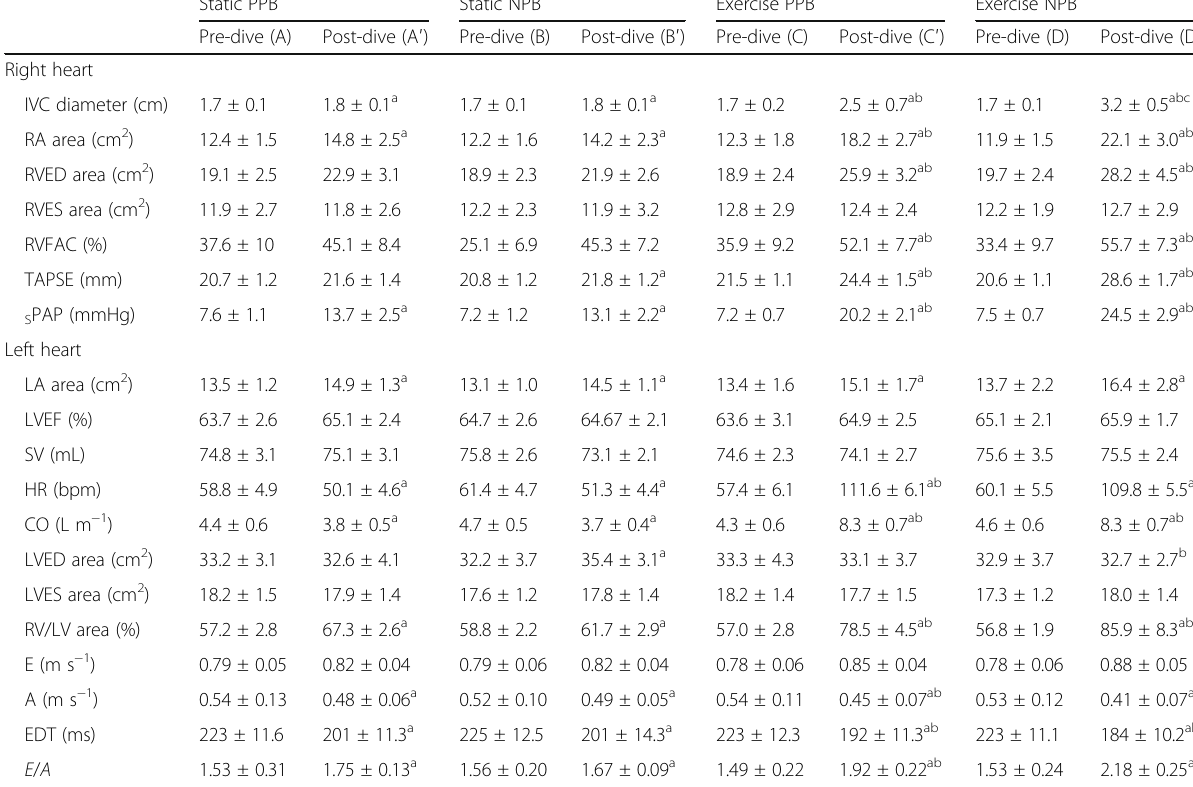
Table 2 Cardiac variables assessed through transthoracic echography in-water at start and end of each dive session Static PPB Static NPB Exercise